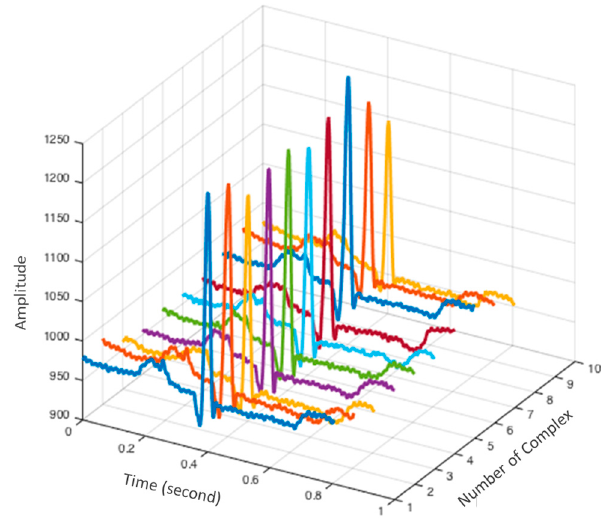
Figure 5. 3D array of P-QRS-T complexes.